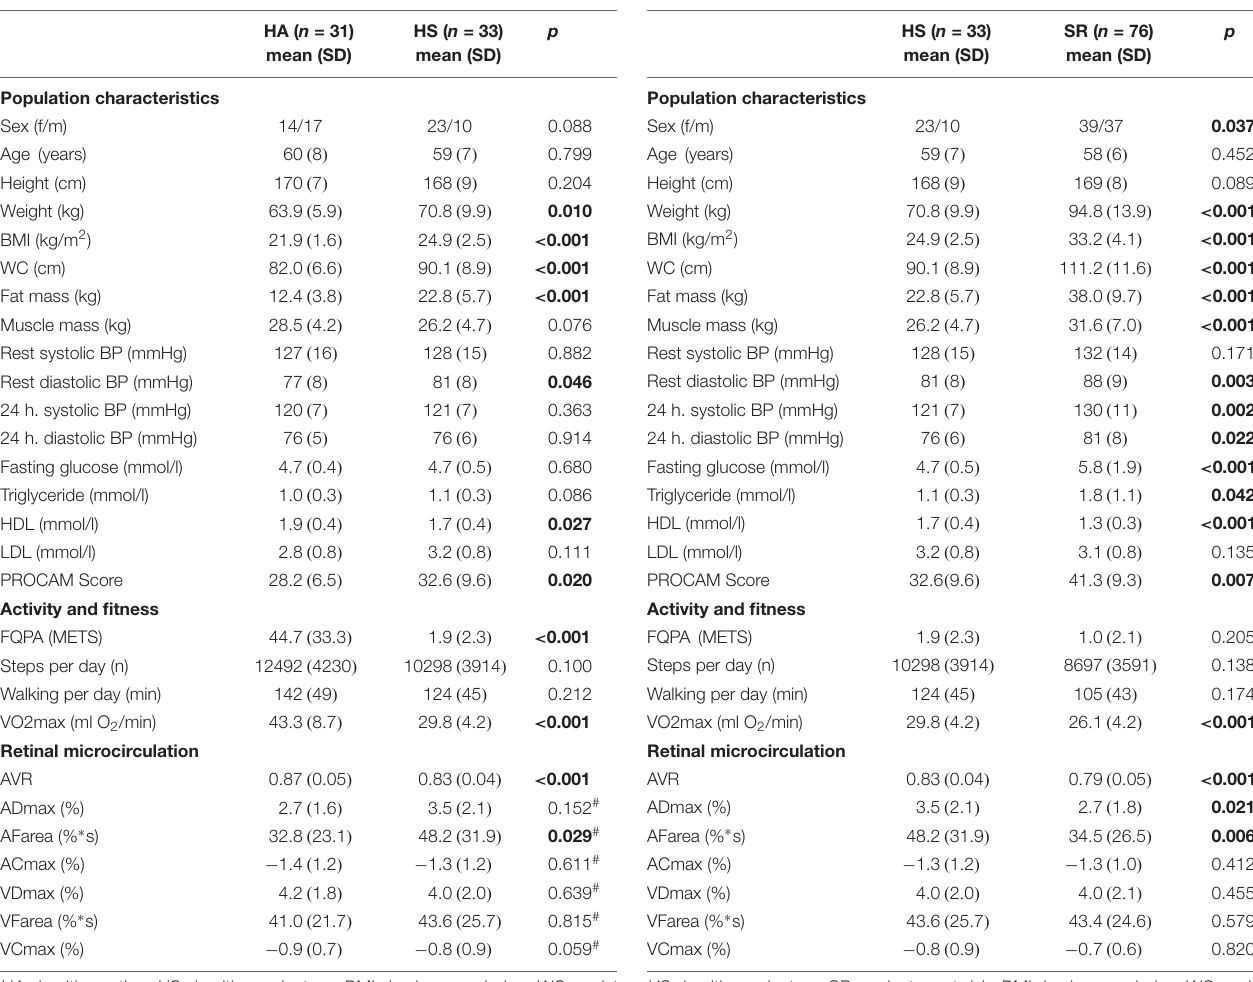
TABLE 3 | Group differences between healthy sedentary and sedentary individuals with increased CV